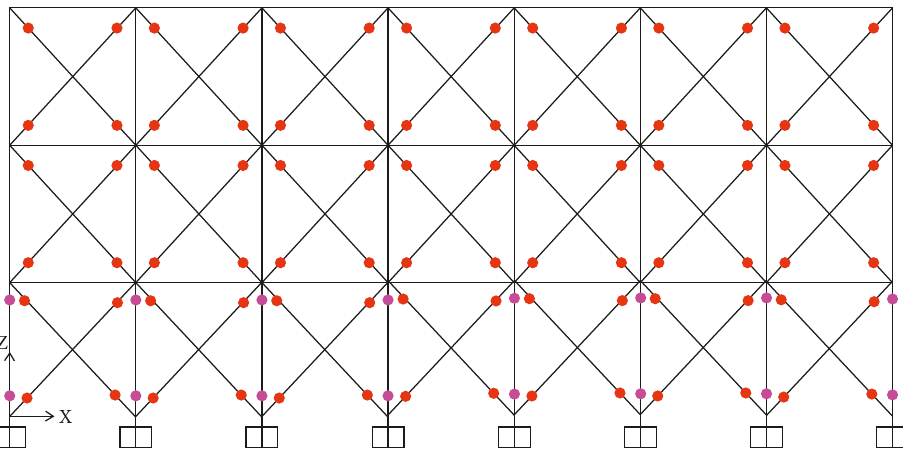
Figure 8: Sequence of hinges formation in the X direction.